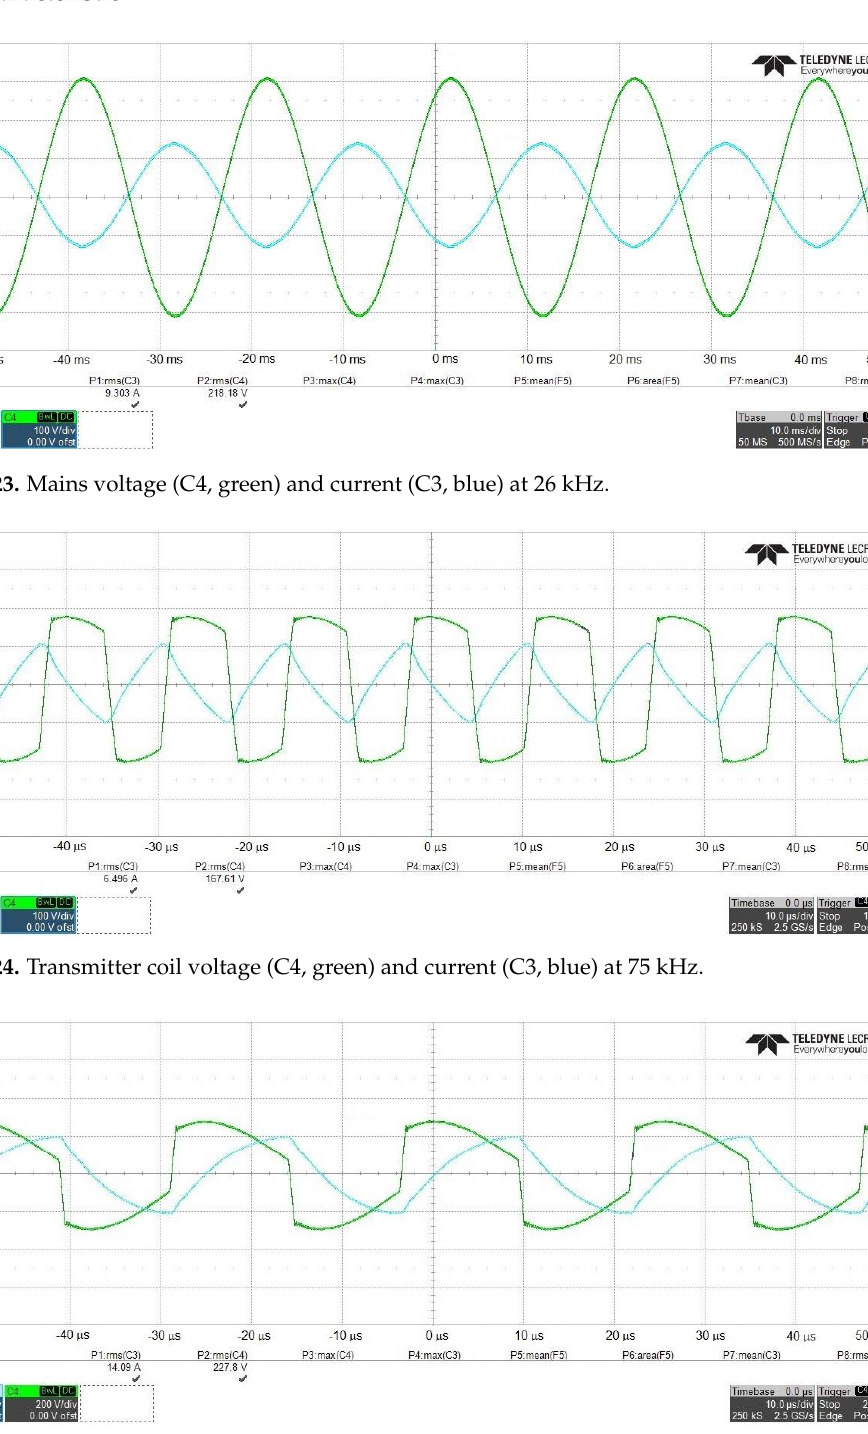
Figure 22. Mains voltage (C4, green) and current (C3, blue) at 31 kHz.